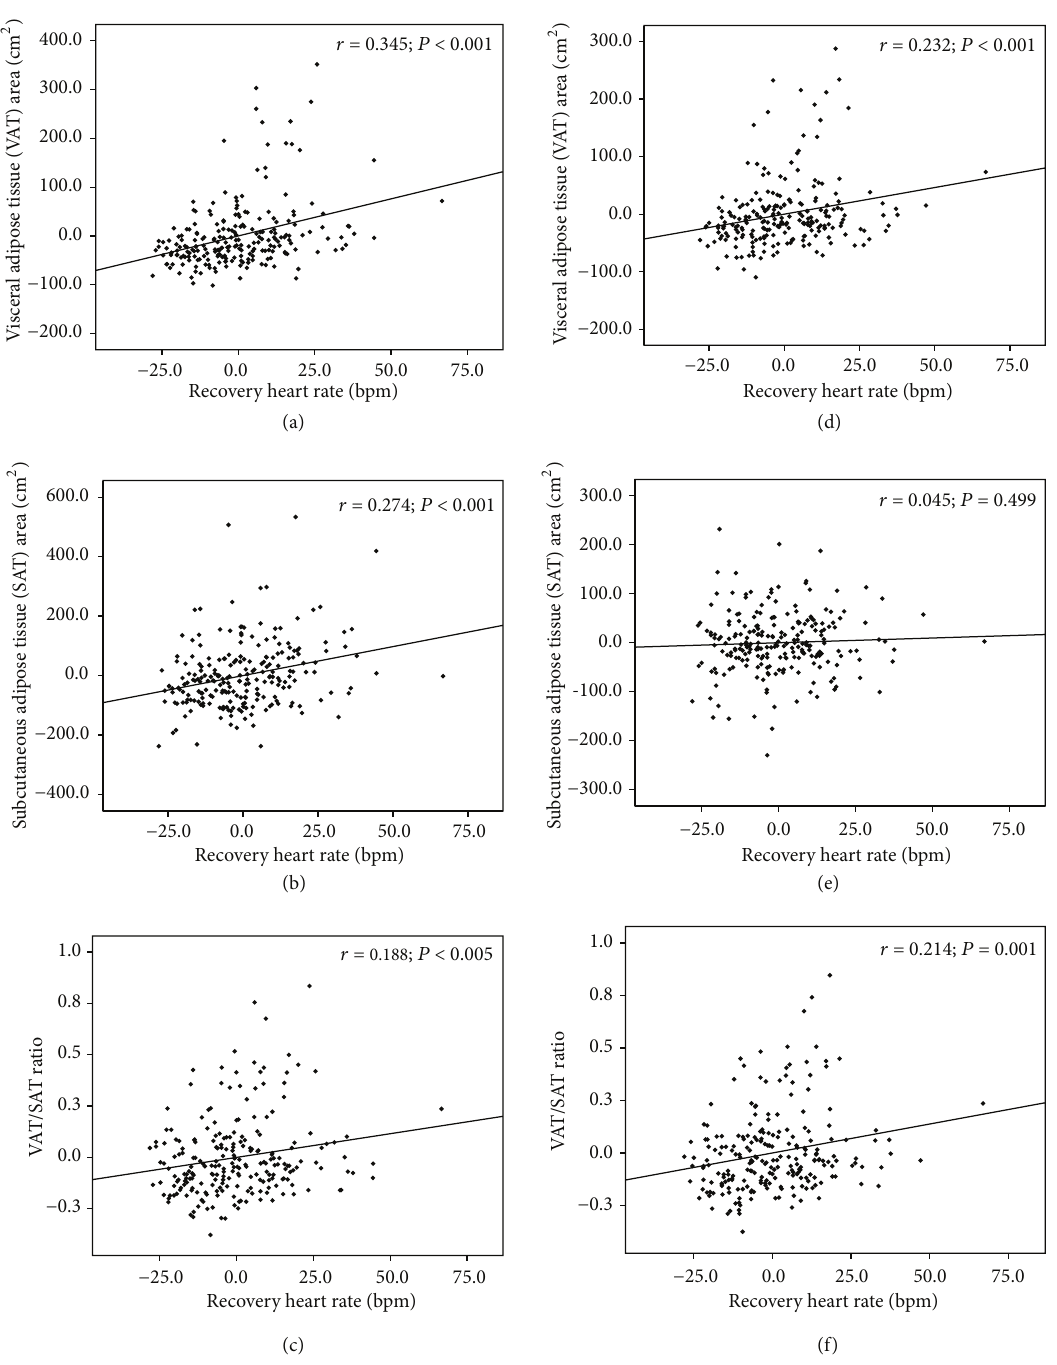
Figure 1: Relationship between fitness level (recovery heart rate) and abdominal adiposity (VAT, SAT, and the VAT/SAT ratio). VAT, visceral adipose tissue; SAT, subcutaneous adipose tissue; VAT/SAT ratio, visceral-to-subcutaneous adipose tissue ratio; 𝑟 : Pearson’s partial correlation coefficient ( 𝑟 = 0 : no linear relationship, 𝑟 = 1 or − 1: perfect linear relationship). 𝑥 -axes are based on calculated residuals from regressing fitness level (recovery heart rate) on age and sex (a, b, and c) and for age, sex, and BMI (d, e, and f). 𝑦 -axes are based on calculated residuals from regressing abdominal adiposity (VAT, SAT, and the VAT/SAT ratio) on age and sex (a, b, and c) and for age, sex, and BMI (d, e, and